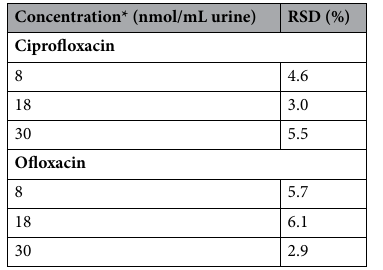
Table 1. Repeatability of ciprofloxacin and ofloxacin extraction. *n =